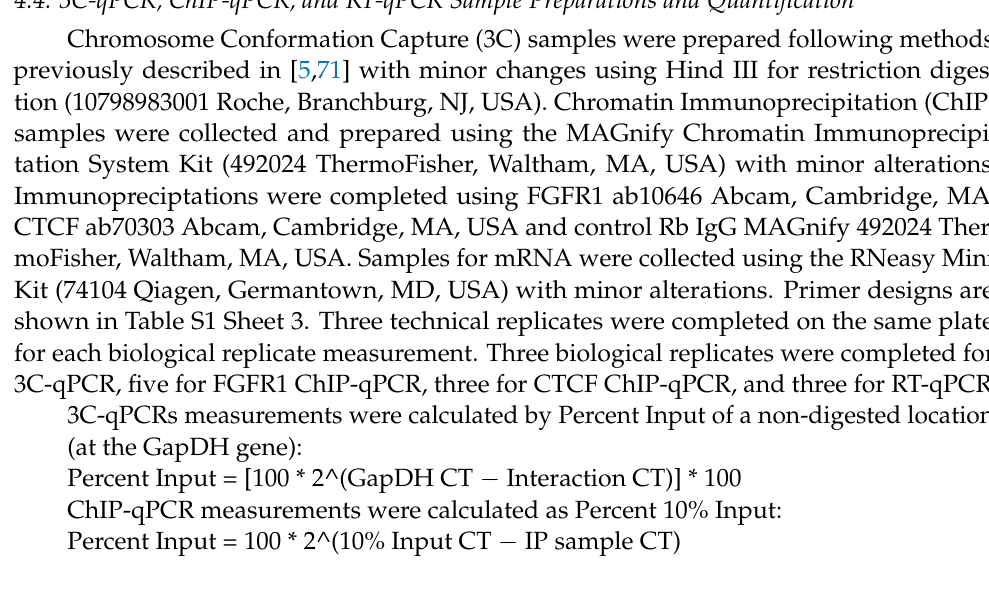
Figure 3. Downregulated TADs express stage specific genes and are reorganized during ESC to NCC — differentiation. At interacting (q<0.001) upregulated and downregulated anchor-anchor midpoints: (A) — Differential gene expression. (B) TAD overlap. (C) Directionality Index. (D) Gene Ontology Category — Enrichment. Two-way ANOVA Tukey Method: ESC versus NCC for each location shown, p<1e-2 p<1e-4 ; p<1e-6 ; p<1e-8 ; p<1e-10 . At TAD borders aligned left and right based on regulated gene directionality (adjusted p<0.05): (E) TAD reorganization. (F) Differential gene expression. (G) — Differential interaction anchor strength. (H) Differential nFGFR1 binding. (I) Differential gene coding — and regulator feature enrichment. Z-Score statistics indicate bins which are outside the mean of all bins — p<0.05 ; p<0.01 ; p<0.005 . (J) Differential chromatin looping. (K) Differential nFGFR1 looping.